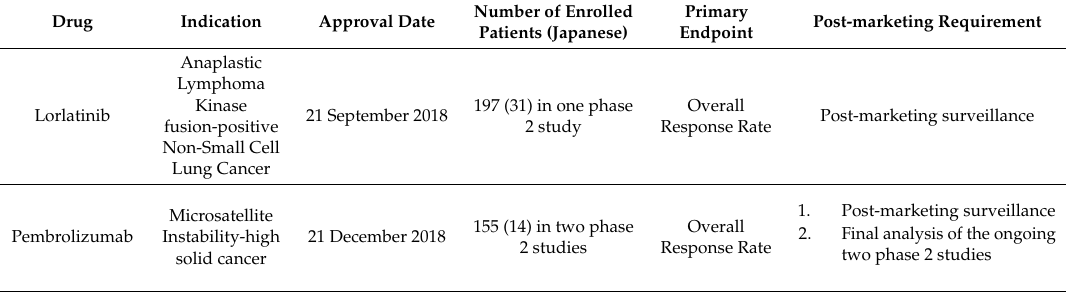
Table 6. Drugs granted conditional approval in Japan as of 31 May